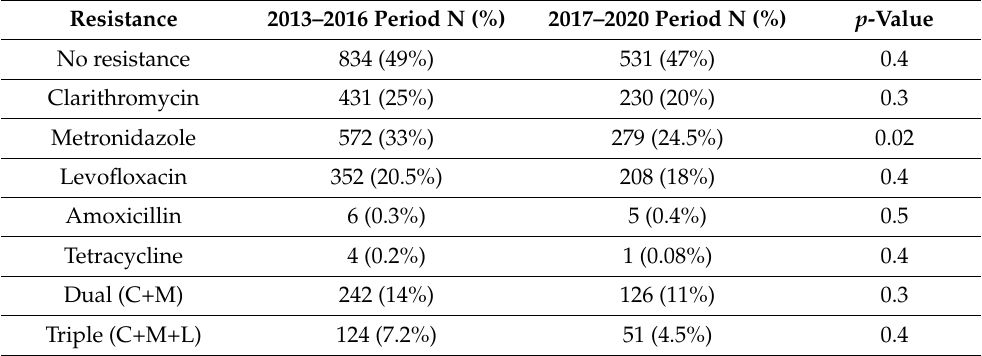
Table 2. Helicobacter pylori antibiotic resistance trends in naïve patients over the two study periods